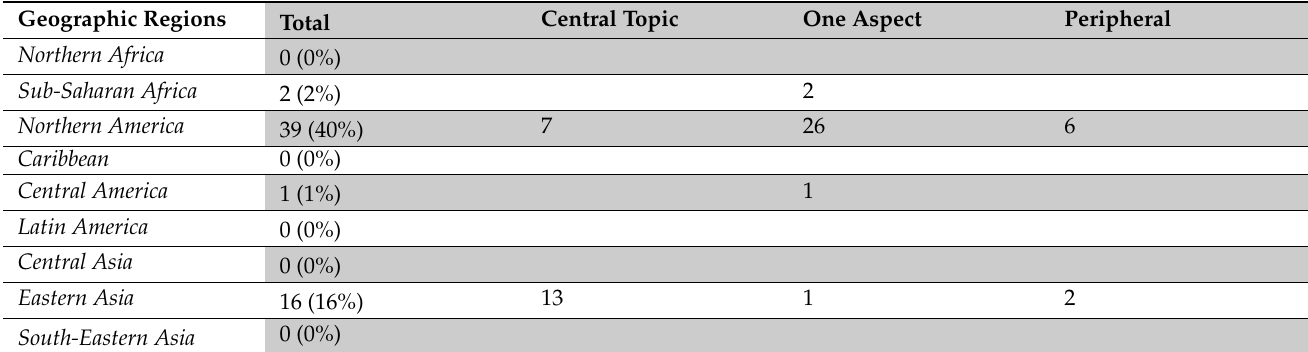
Table A4. Geographical spread of included articles ( n = 72), also distributed in respective categories. The geographical origin of articles was divided in accordance with the regional classification of the United Nations